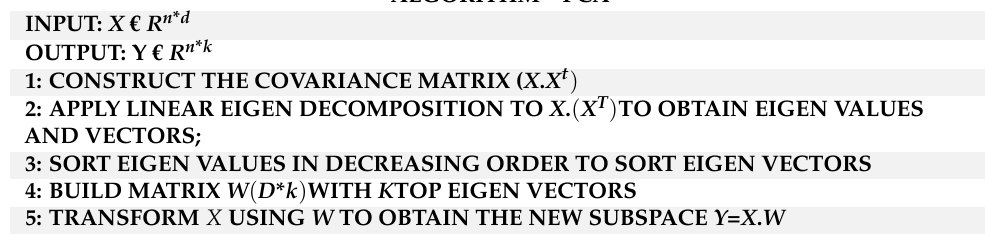
Table 1. PCA algorithm steps.